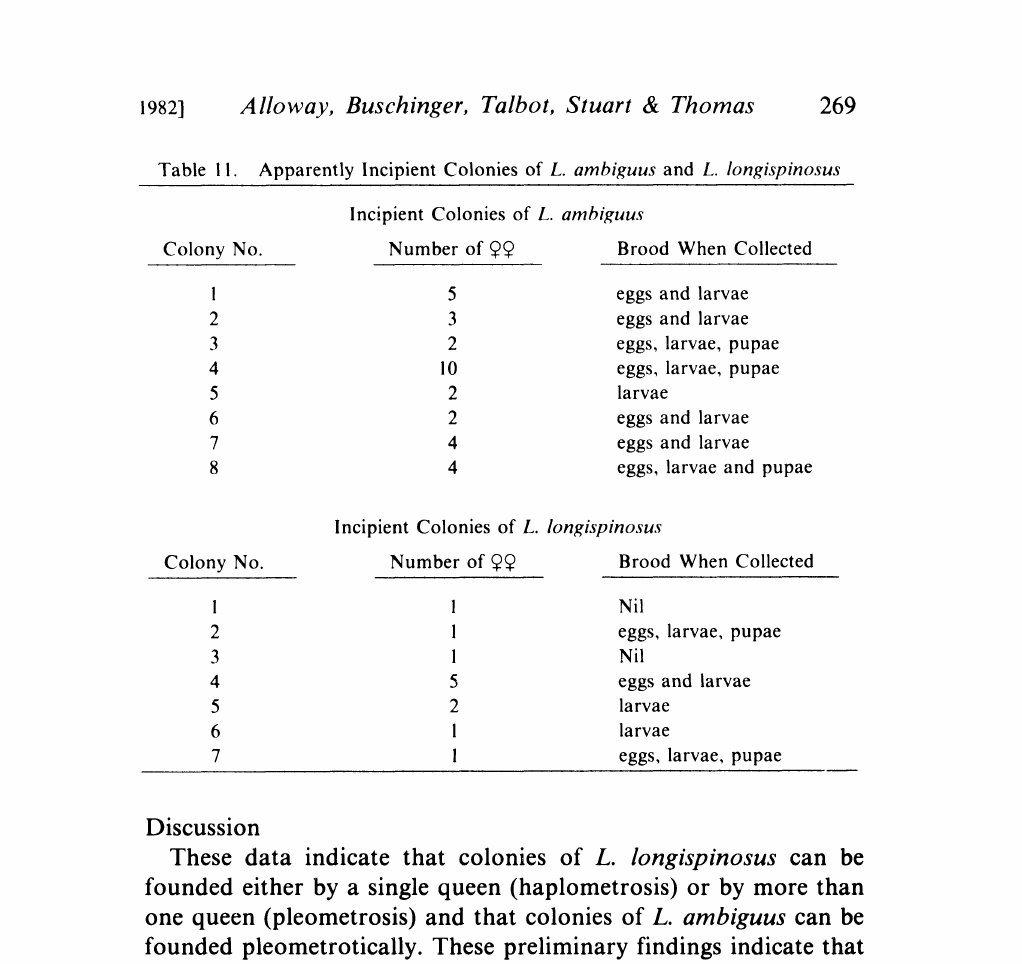
Table I. Apparently Incipient Colonies of L. ambiguus and L. iongispinosus Incipient Colonies of L. ambiguus Colony